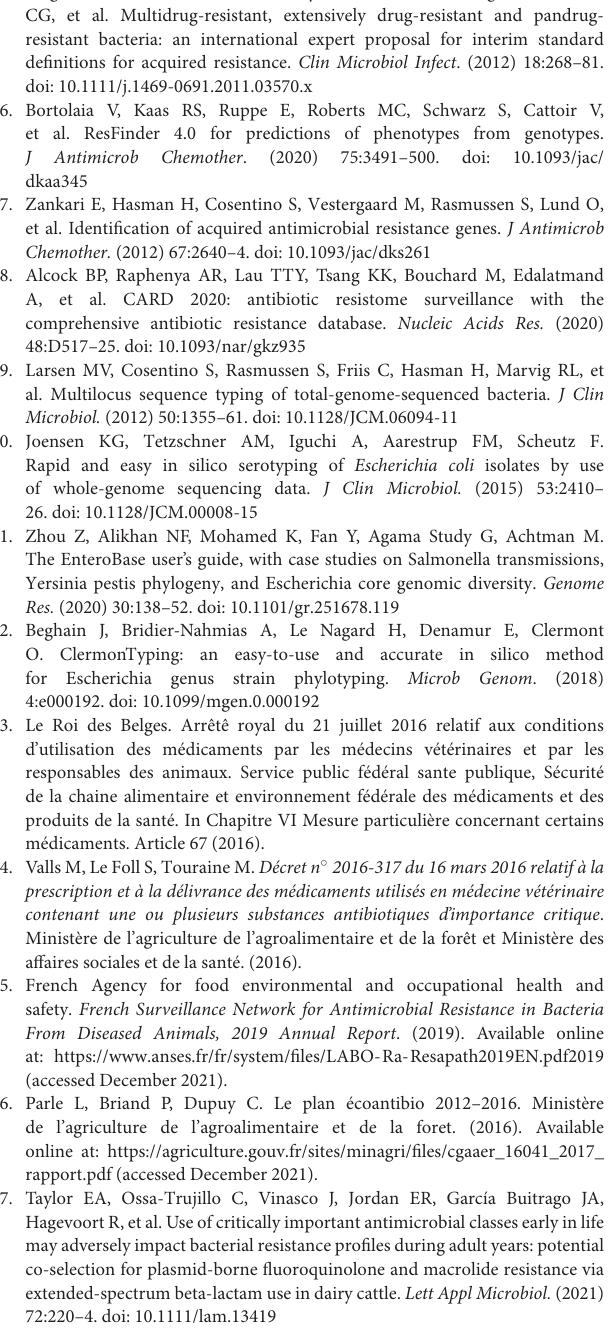
Supplementary Figure S4 | Comparison of the proportion of isolates with a putative ESBL/AmpC Escherichia coli per sample type (manure pit, cows, calves, herd) from 87 dairy farms from Québec, Canada, pre (gray) and post (black)